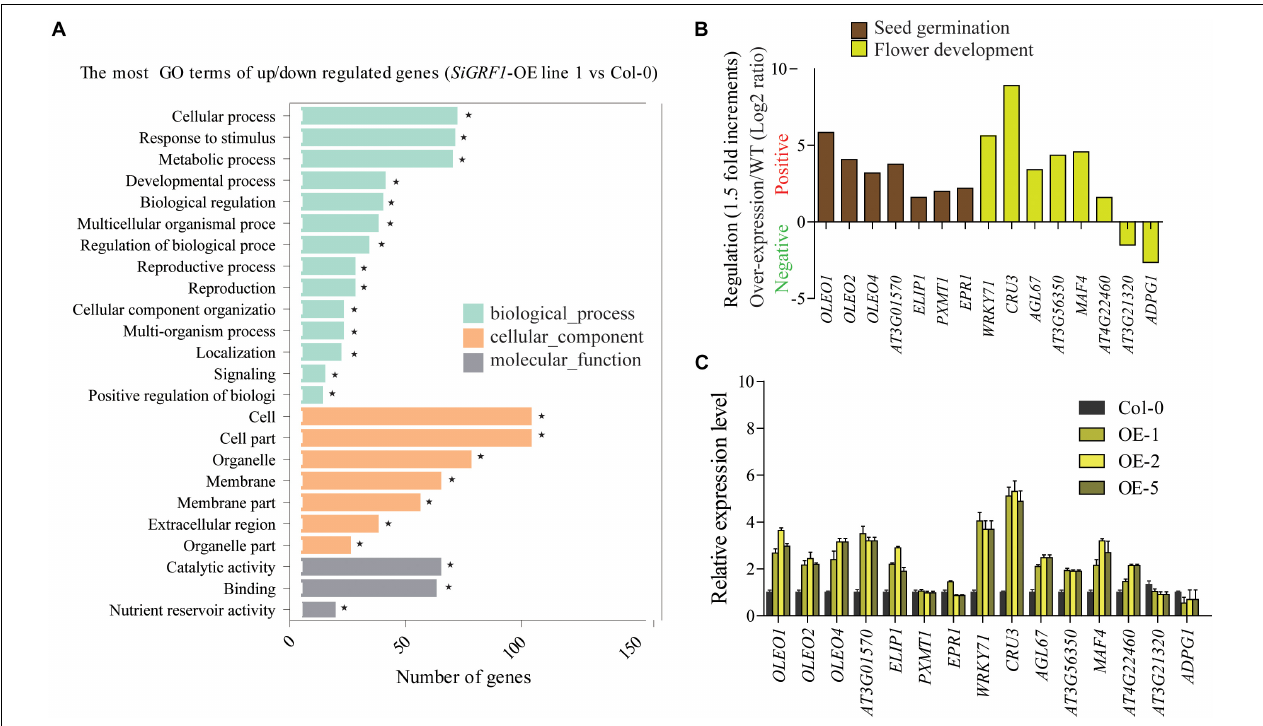
FIGURE 6 | SiGRF1 activity can change the expression of genes related to seed germination, stress response, and flower development. (A) The enrichment of GO terms for genes that were differentially expressed between SiGRF1-OE line 1 and Col-0 was analyzed using RNA-seq. Vertical coordinates represent enriched GO terms, and horizontal coordinates represent the numbers of DEGs for these GO terms. The light green columns represent the GO terms for biological processes, orange columns represent the GO terms for cellular components, and gray columns represent the GO terms for molecular functions. Asterisks indicate significantly enriched GO terms. (B) Expression levels of genes related to seed germination and flower development from RNA-seq data. The brown columns represent seed germination, and the yellow columns represent flower development. (C) qPCR verified the accuracy of the RNA-seq data. Vertical coordinates represent fold changes, and horizontal coordinates represent different genes. The relative expression levels of those genes in Col-0 were set to “1.” Arabidopsis actin2 (AT3g18780) was used as a reference. Error bars indicate the SDs. The data represent the means ± SD of three biological replications. Asterisks (* and **) indicate significant differences (* P < 0.05 and ** P < 0.01) compared with Col-0 (Student’s t